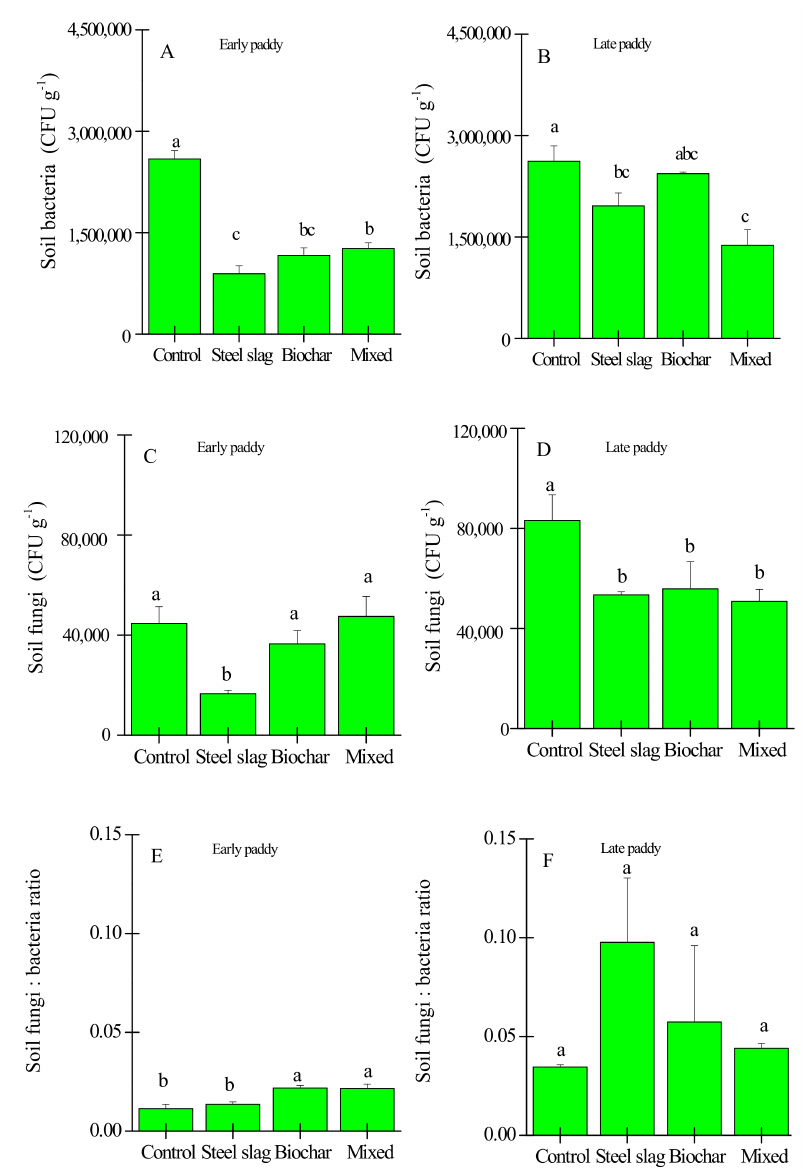
Figure 4. Mean colony count of bacteria ( A , B ), fungi ( C , D ), and fungi:bacteria ratio ( E , F ) in the treatment and control plots in the early and late paddy fields. Different letters represent significant difference in mean values among treatments ( p < 0.05, n =